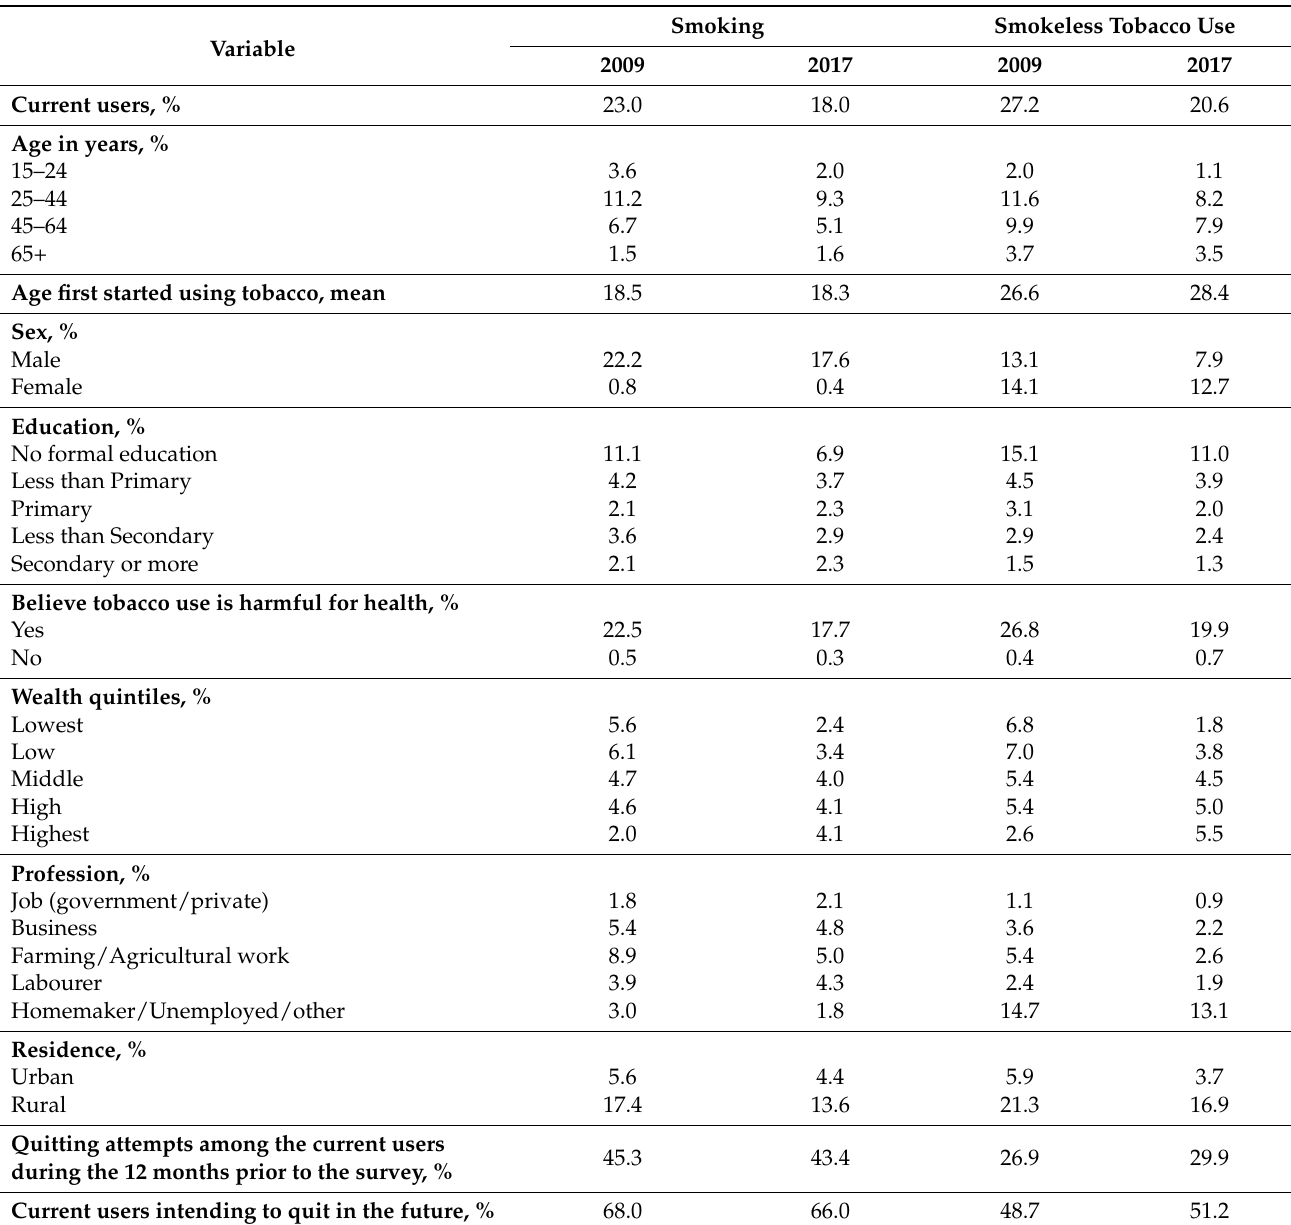
Table 1. Demographic features of the smokers and smokeless tobacco users in 2009 and